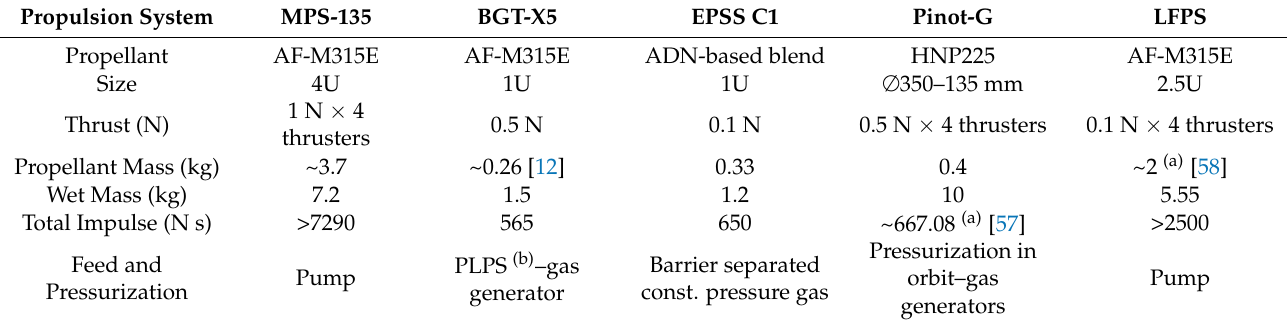
Table 12. Performance data and specifications of state-of-the-art small satellites green monopropellant propulsion systems. Propulsion